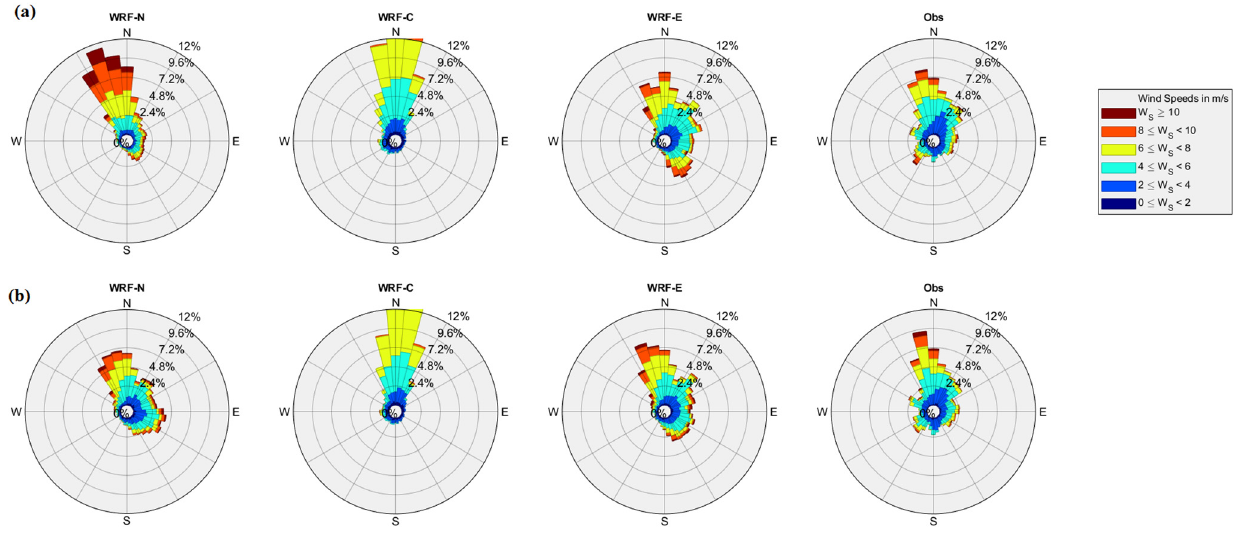
Figure A7. Monthly averaged wind speed in m s − 1 from the models and observations at the locations ( a ) Dongsha, ( b ) Zhanjiang, and ( c ) Hong Kong.